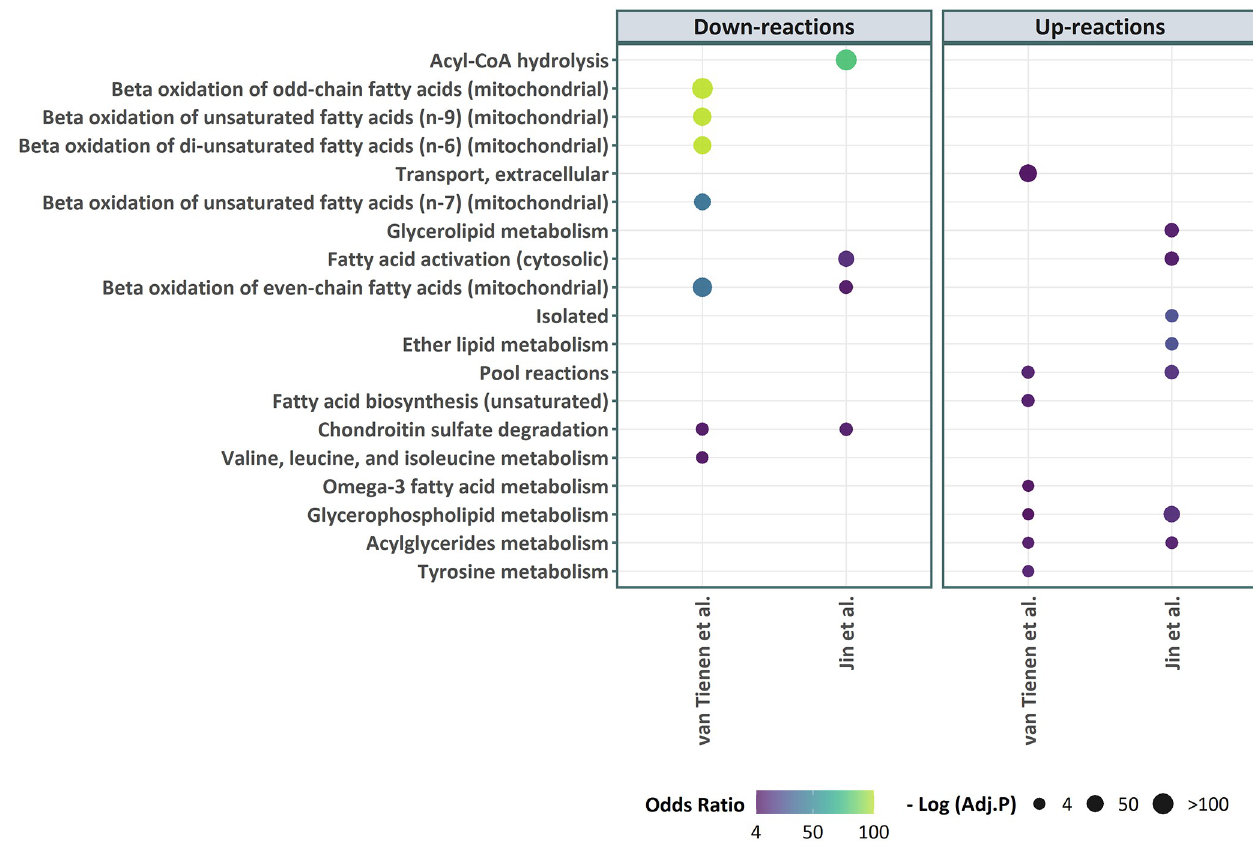
Fig 3. Enriched metabolic subsystems (FDR < 0.05) among the in T2D patients based on flux changes predicted using Δ FBA. The flux changes were computed based on the transcriptome datasets from two T2D studies: van Tienen et al . [43] (GSE19420) and Jin et al . [44] (GSE25462). The statistical significance of the over-representation is shown by the size of the markers—larger markers have smaller adjusted p -values—while the odds ratio is shown by the color of the markers.